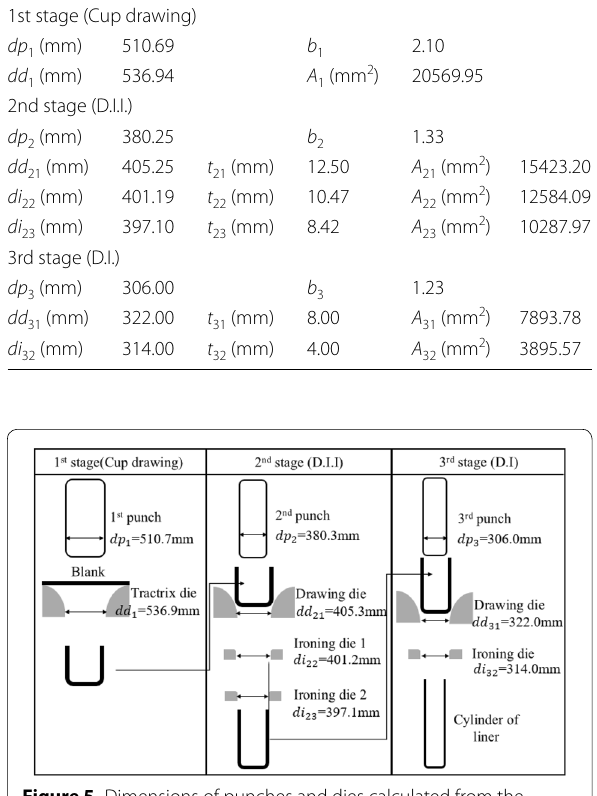
Table 2 Calculation result of D.D.I. process design